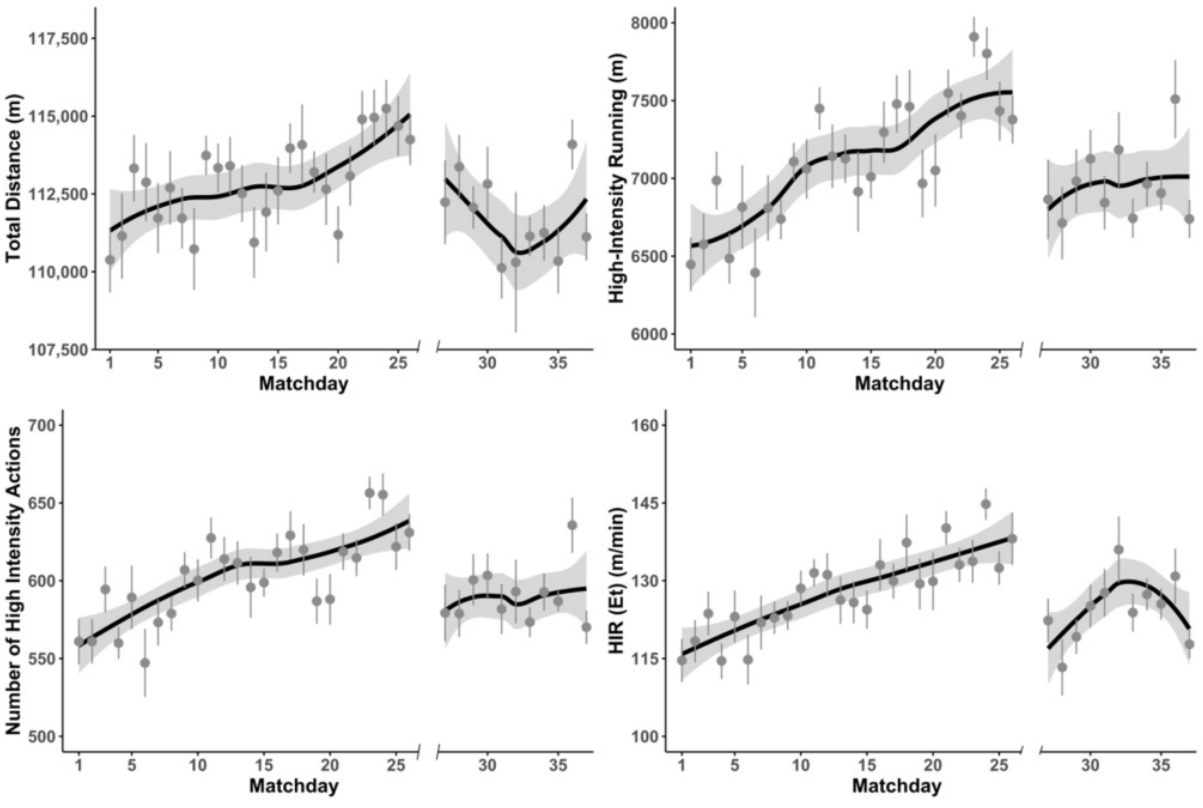
Figure 3. Changes in selected physical performance variables before and after the pandemic lockdown in German Bundesliga teams during official matches (HIR—high-intensity running, E t —effective playing time). Table 2. Changes of physical match performance before and after the COVID-19 lockdown in Polish Ekstraklasa.